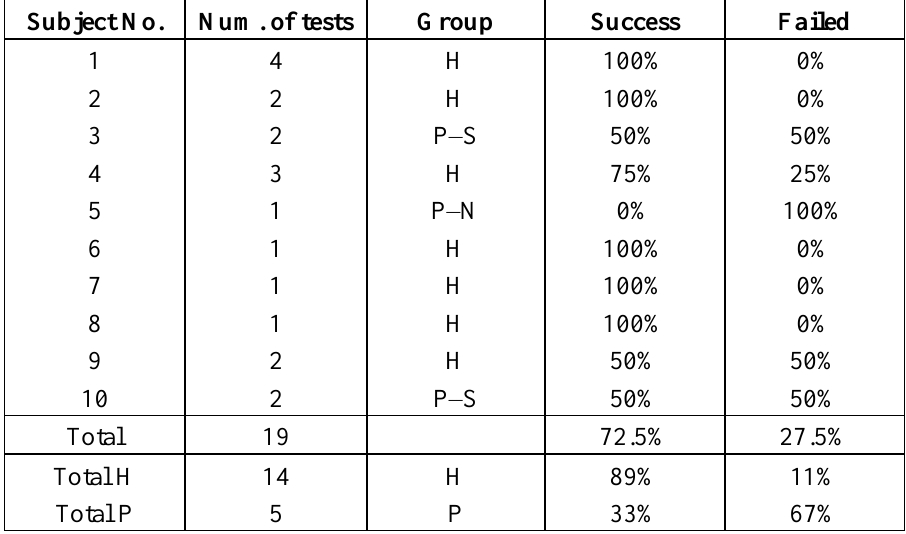
Table 5. Algorithm detection statistical